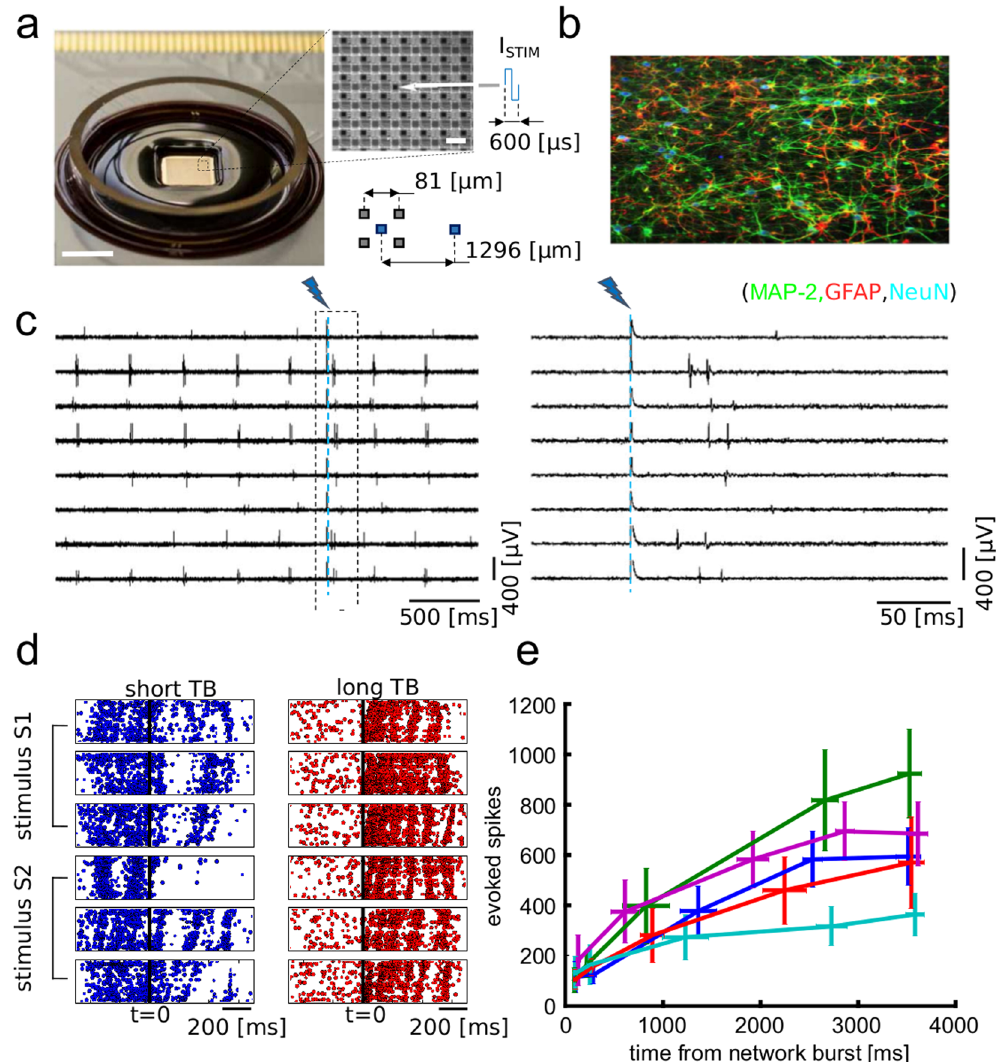
Figure 1. High-resolution recordings of ongoing activity and electrically evoked responses in neuronal networks. ( a ) View of a CMOS-MEA chip and close up on the electrode array. The arrow indicates an electrode for electrical stimulation. Scale bars represent 5 mm (left) and 80 µ m (close-up, right). ( b ) Immunofluorescence image of a hippocampal neuronal network, obtained in separate pilot experiments in which neurophysiology was not performed, grown on-chip for 18 DIVs and stained for MAP-2 (green), a neuron-specific marker for dendrites, GFAP (red), a marker for astrocytes and NeuN (blue), a maker for neuronal nuclei. ( c ) Raw traces (left) and close-up around the stimulation instant (right) of representative electrodes showing ongoing and evoked spiking activity. ( d ) Raster plots illustrating the difference between evoked network response obtained with stimuli delivered at short (left) and long (right) time TB. Plots for two stimuli (S1, S2), delivered from two different electrodes, and for three stimulation trials are reported. As shown, for short TB (left) the response to a stimulus delivered at t = 0 is weaker than the response obtained for stimuli delivered at long TB (right). ( e ) Quantification of the averaged evoked number of spikes over a time window of 100 ms after stimulation as function of TB (8 different stimuli, 60 trials per stimuli). Each trace refers to a different cell culture. The TBs were grouped in quintiles. The reported mean and SEM on the x axis are computed over the quintiles of the TB distribution. The mean and SEM on y axis are computed on the corresponding evoked